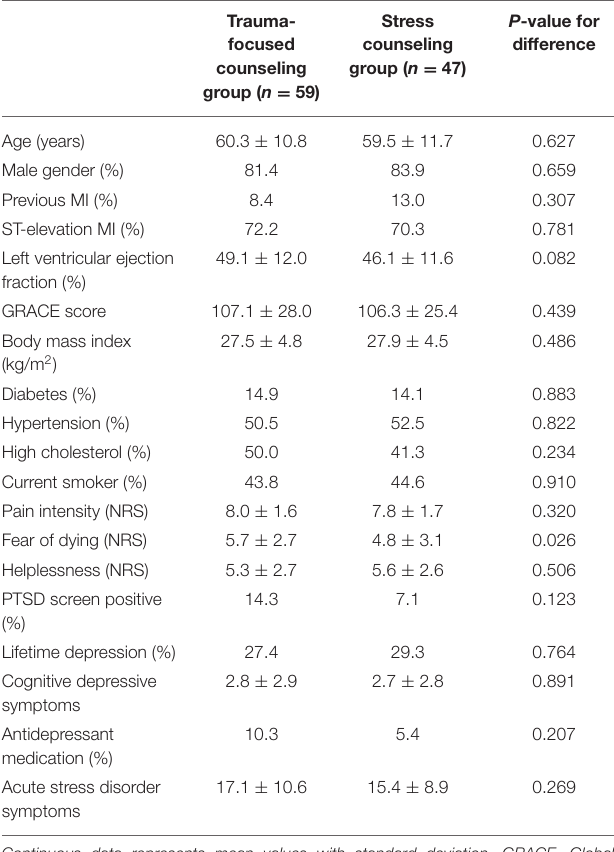
TABLE 1 | Baseline characteristics of the 106 study participants per type of